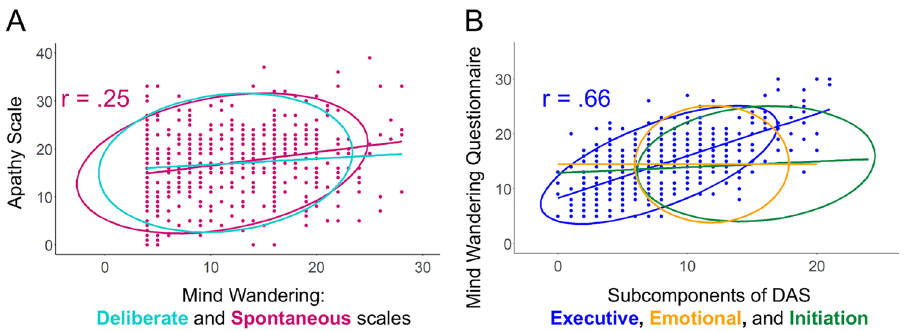
Figure 1. Scatter Plots of the Correlations Between Mind Wandering and Motivational Indices in Study 1. Note Data for non-significant correlations after multiple corrections are only shown by the 95% elliptical confidence region of the multivariate t-distribution. DAS = dimensional apathy scale. Higher scores on the apathy scale and DAS indicate increased amotivation.